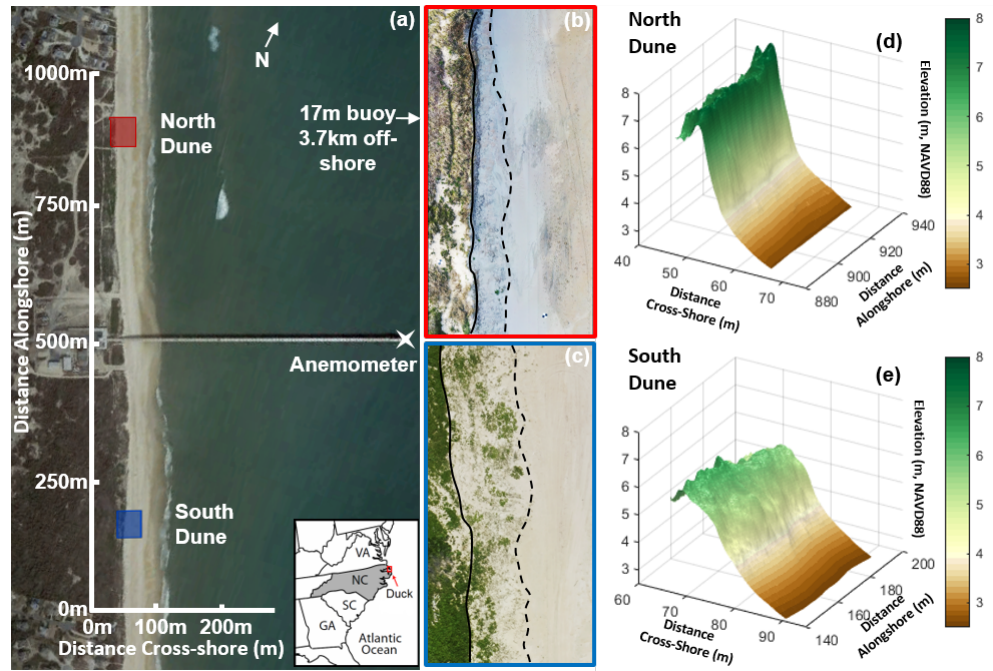
Figure 1. Overview of field sites. ( a ) Aerial imagery of the Field Research Facility and regional inset map. The north dune field site is highlighted in red, and the south dune field site in blue. The location of the anemometer used in this study is shown by the white star. ( b , c ) Example high-resolution ortho-imagery with the approximate dune crest (solid) and dune toe (dashed) position indicated, and ( d , e ) digital elevation models (colors show elevation in m, NAVD88) of the North and South sites,